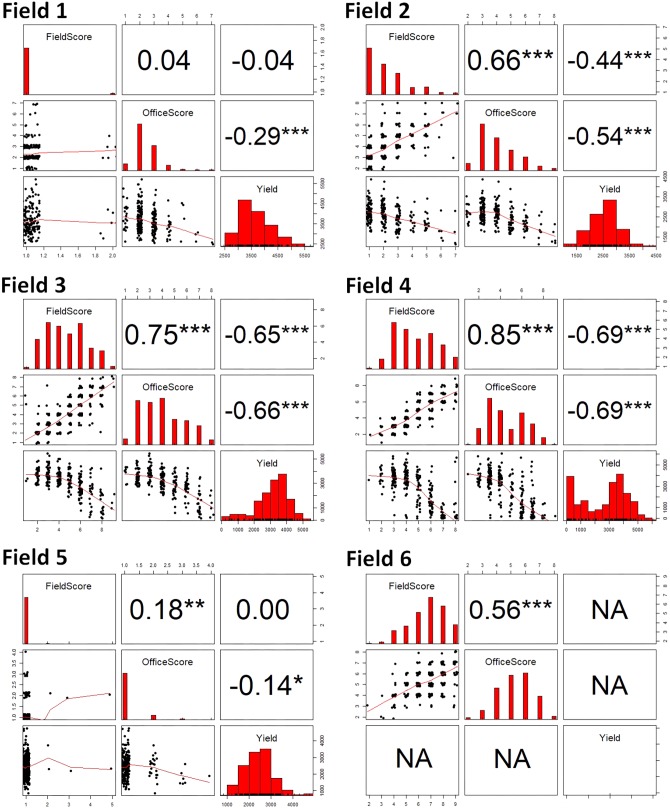
The scatterplots and Pearson’s correlation coefficients among iron deficiency chlorosis field score, office score, and yield for the six fields in this study. The significance levels of the Pearson’s correlation coefficients are: ∗∗∗ at 0.001 level, ∗∗ at 0.01 level, and ∗ at 0.05 level.